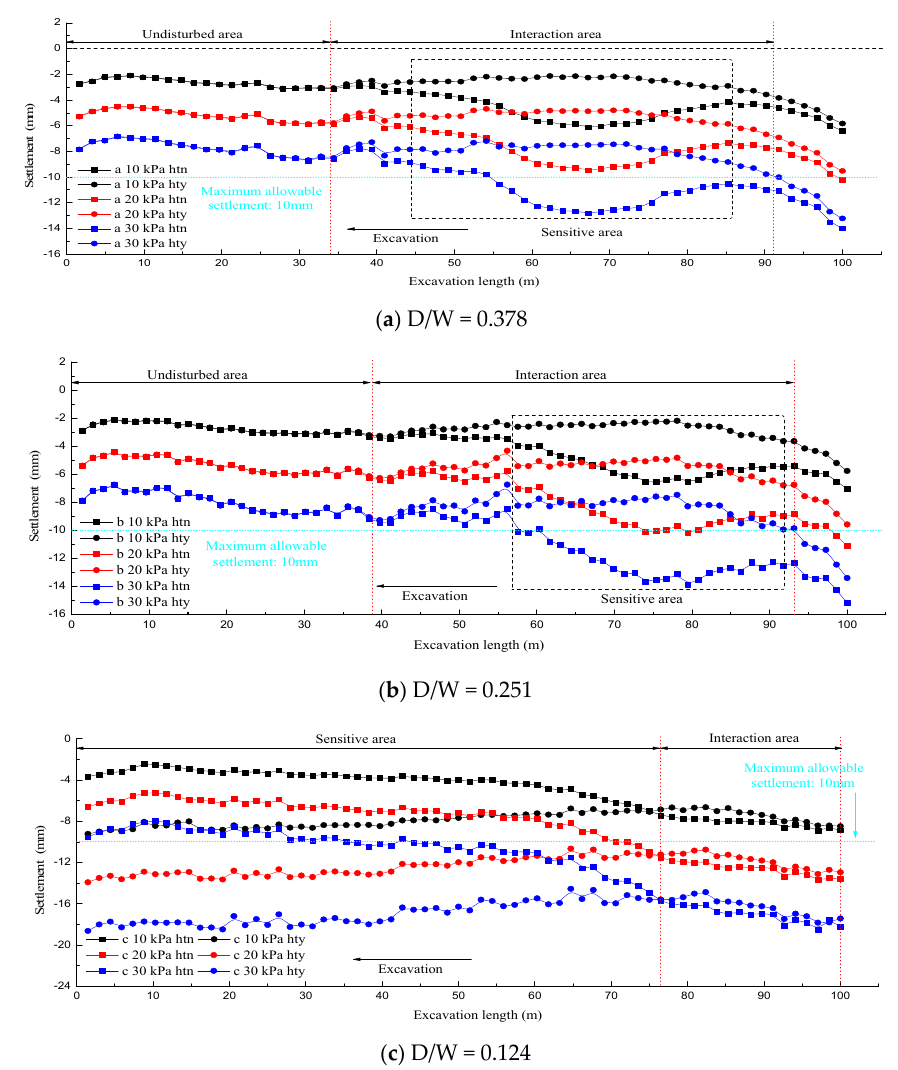
Figure 8. Longitudinal surface settlement of models A-A to C-C.